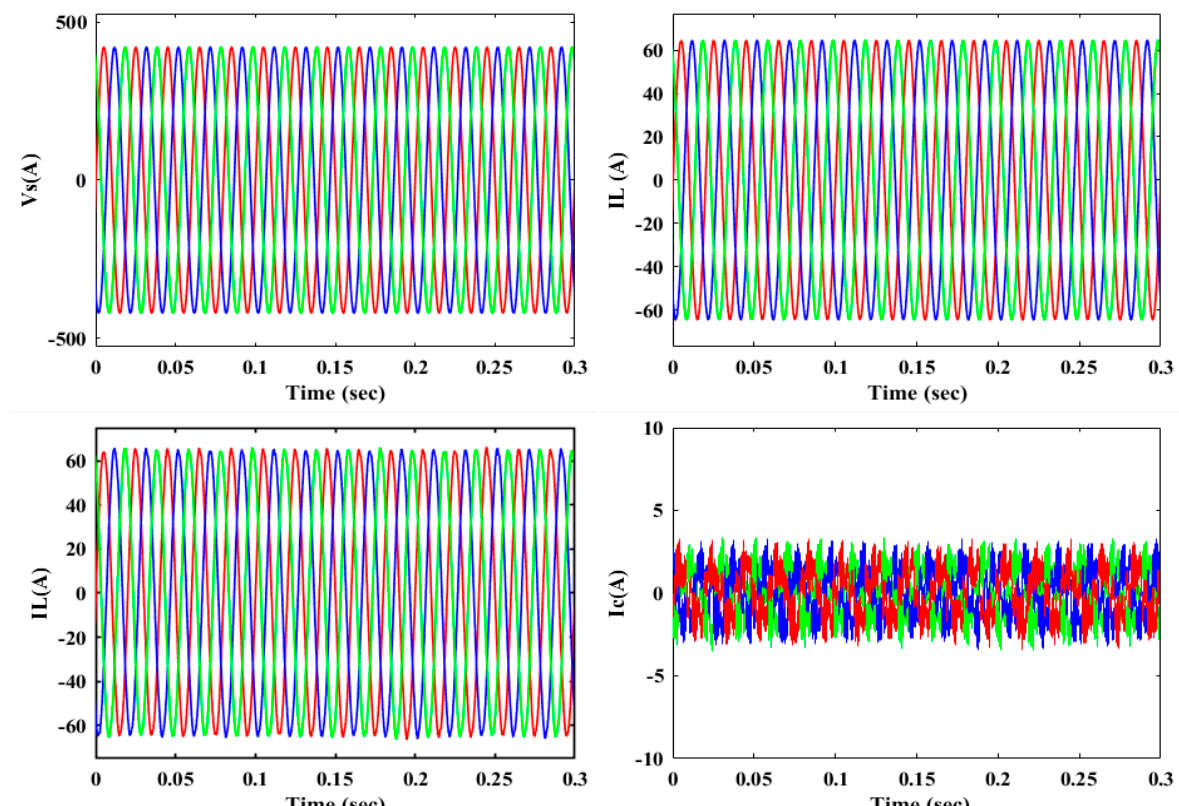
Figure 13. PCC voltage V(s), Grid current (Is), Load current (I L ), Inverter Terminal out current I(c).